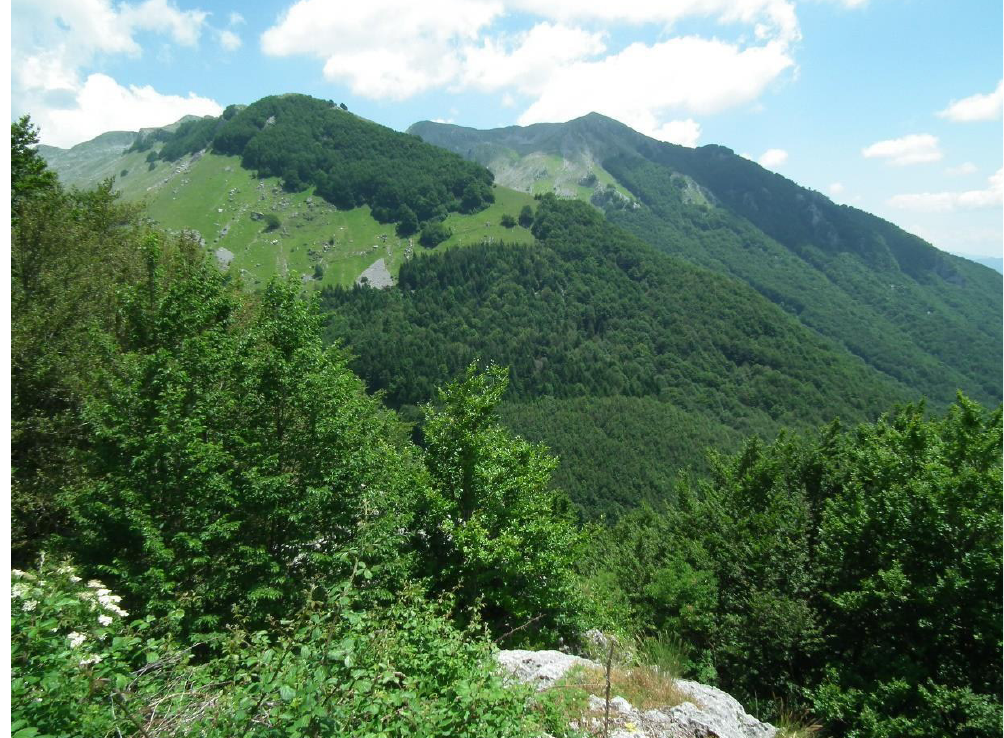
Fig. 24. Forest of Fagus sylvatica L. in the Apennine Mountains, where Tachydromia apterygon Plant & Deeming, 2006 can be